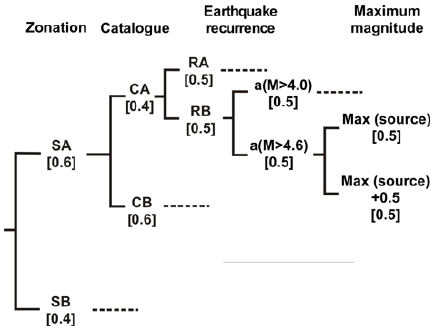
Figure 4. Logic tree used for hazard calculation. The weight of each branch is shown in square brackets (modified from Vilanova and Fonseca, 2007).